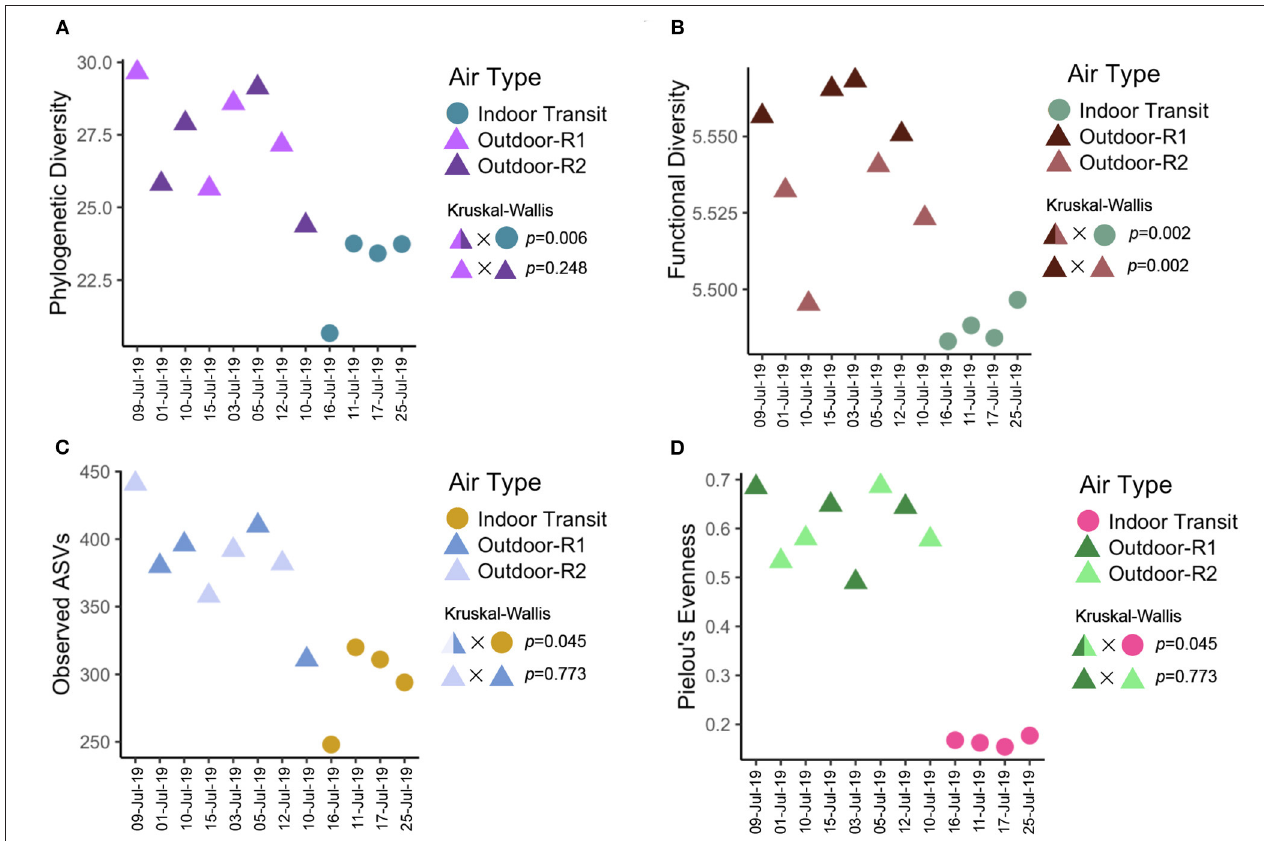
FIGURE 5 | Alpha Diversity Metrics separated by air type (circle: indoor transit, triangle: outdoor) and route driven for outdoor samples (color) with date of collection on the x axis. Shape/Color X Shape/Color indicates the factors used in hypothesis testing with the test above and p -value to the right. It should be noted the split color is for visualization and statistical tests were conducted on outdoor ∼ indoor samples. (A) Faith’s phylogenetic diversity (PD). (B) Inferred functional diversity calculated using the Shannon index on PICRUSt functional pathways. (C) Observed number of ASVs. (D) Pielou’s evenness